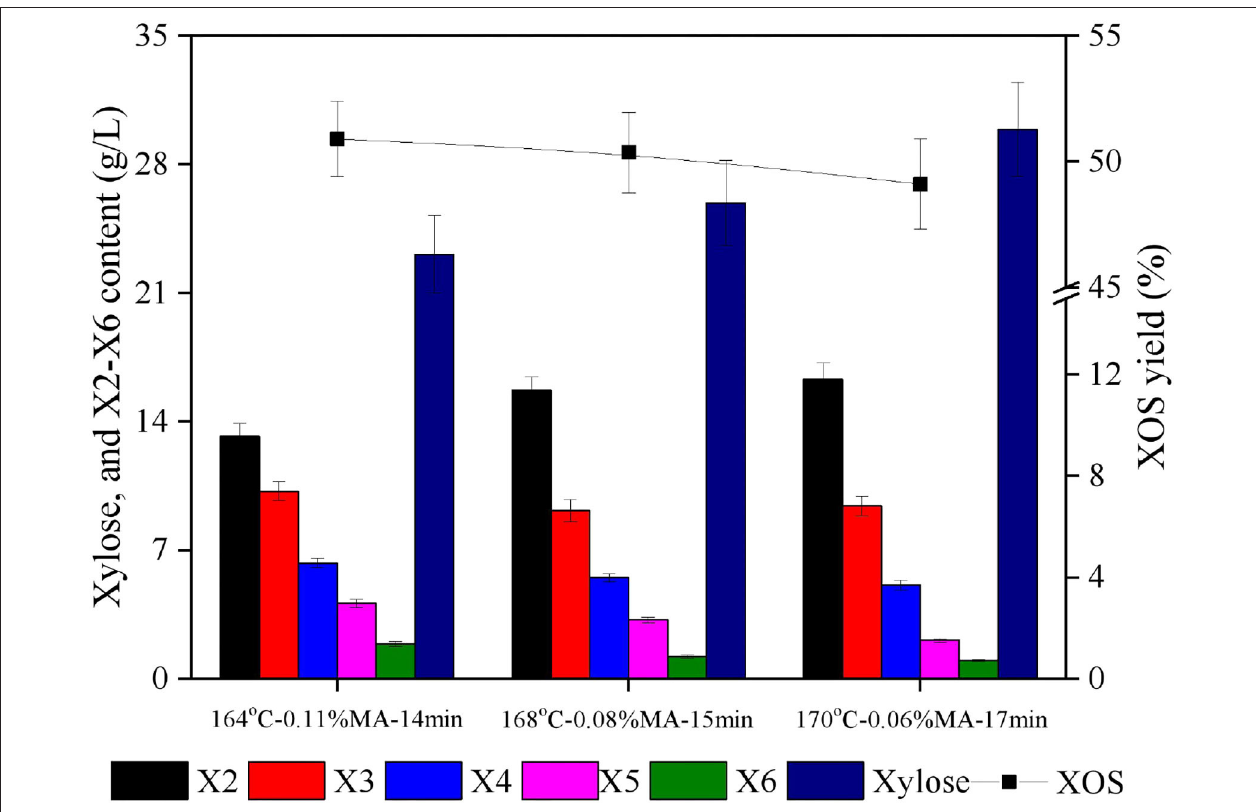
FIGURE 4 | Hydrolysate component distributions and XOS yields for three chosen conditions. X2: xylobiose; X3: xylotriose; X4: xylotetraose; X5: xylopentaose; X6: xylohexaose; XOS: xylooligosaccharides = X2 + X3 + X4 + X5 + X6; MA: maleic